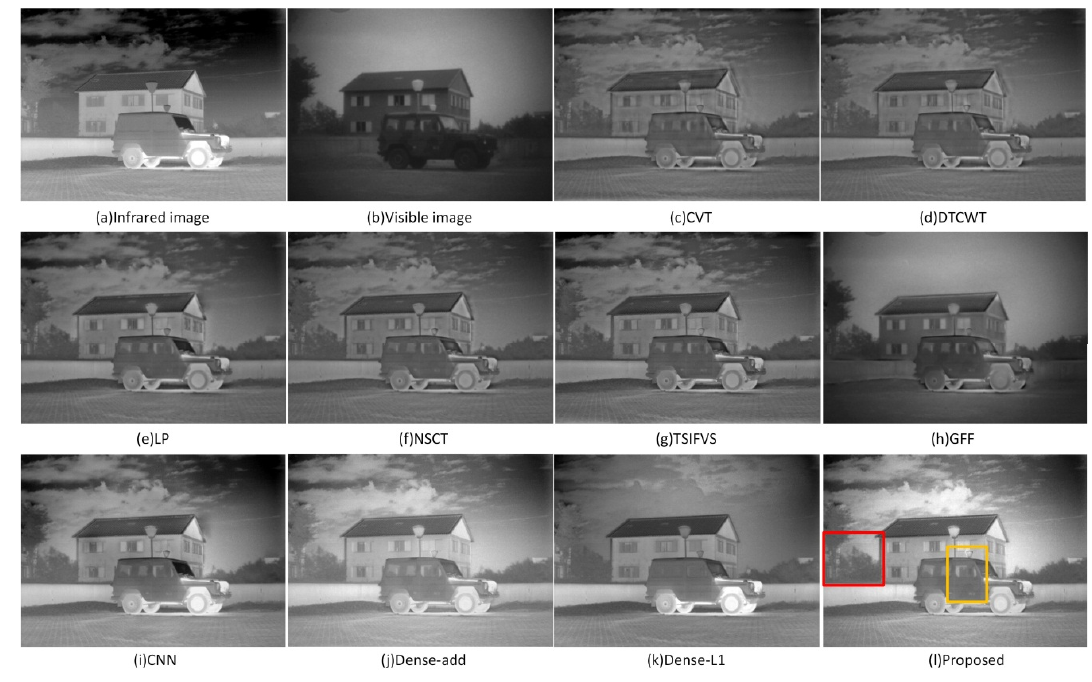
Figure 8. Fused images of “Marne_04”.